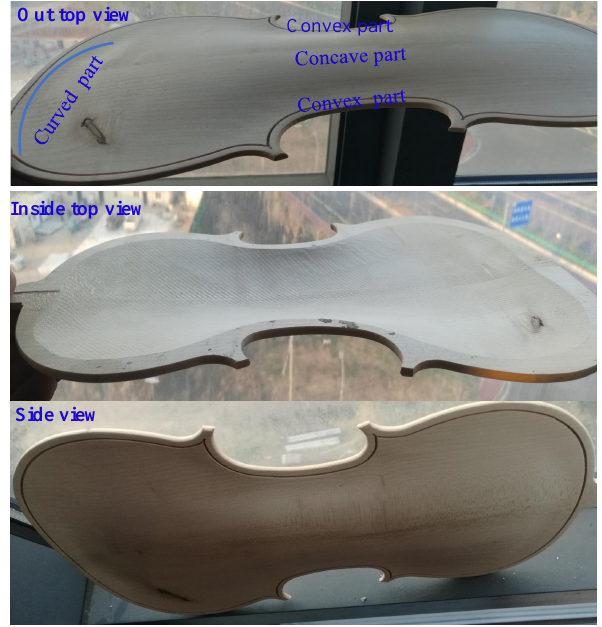
Figure 9. Violin complex